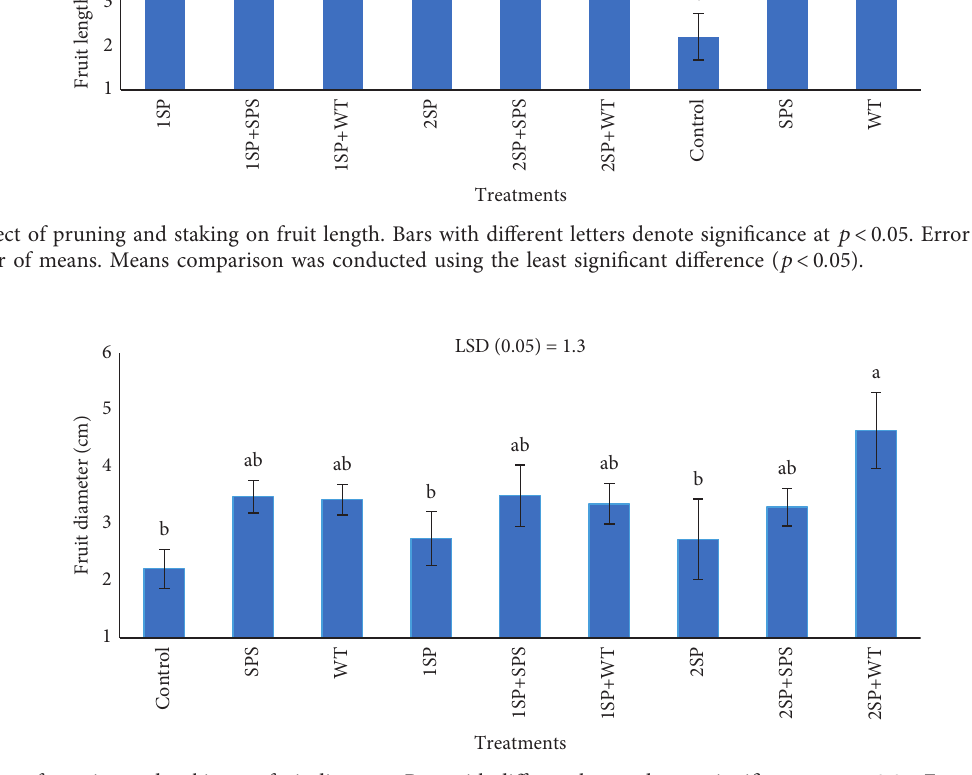
Figure 2: Effect of pruning and staking on fruit diameter. Bars with different letters denote significance at p < 0 . 05. Error bars denote the standard error of means. Means comparison was conducted using the least significant difference ( p < 0 . 05). Table 1: Marketable fruits weight (kg/ha) of tomato under different pruning and staking methods. Means comparison based on the least significant difference